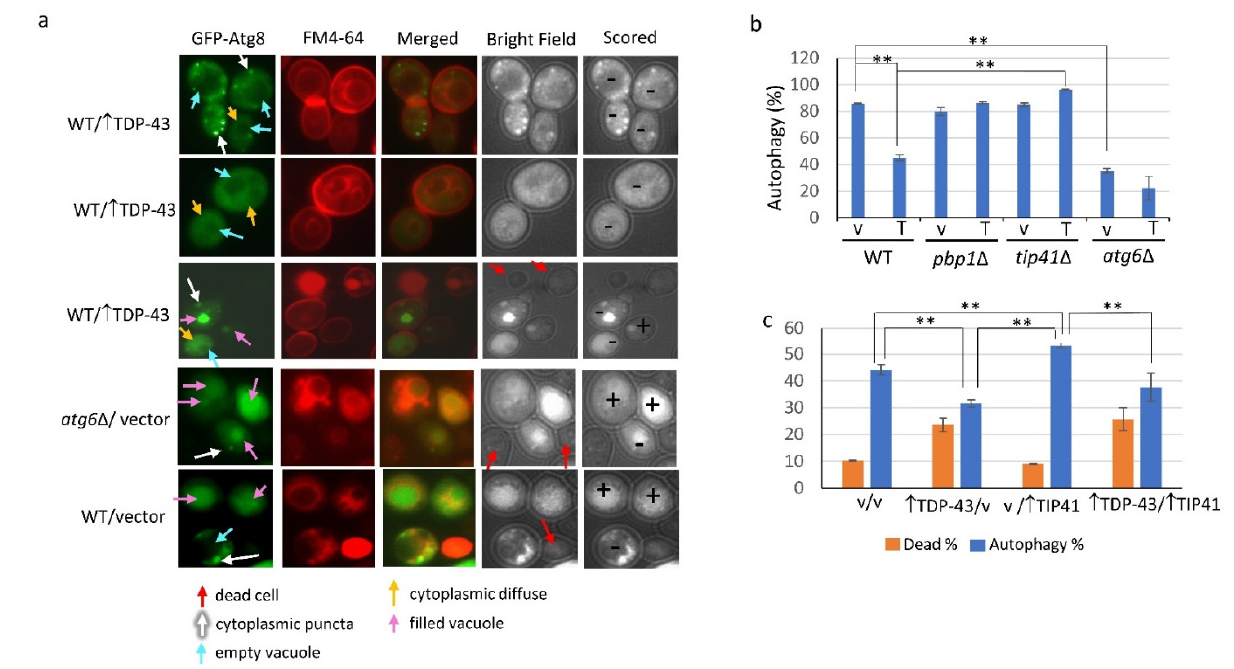
Figure 2. Microscopic assay showing TDP-43 overexpression reduces autophagy. Triple transformants analyzed in Figure 1a were inoculated at 0.02 OD 600 in the presence of 1.6 nM FM4-64 to visualize cell membranes and vacuoles in plasmid selective galactose supplemented with 2% raffinose and 50 µ M Cu ++ for 18 hrs at 30 ◦ C with shaking. Cells were scored for autophagy using the CUP1 controlled GFP-ATG8 reporter by microscopic determination of the location of the fluorescence. ( a ) FM4-64 staining, trypan blue staining and GFP fluorescence of cells expressing GFP-ATG8 are shown in representative cells to illustrate scoring. Cells with accumulation of diffuse fluorescence in the cytoplasm without a concentration of fluorescence in the vacuole, or fluorescence in the cytoplasm in foci even with accumulation in the vacuole, were scored as having delayed or blocked autophagy (-). Cells with fluorescence in the vacuole without punctate cytoplasmic foci, or live cells with no fluorescence, were scored as having autophagy (+). Dead cells were detected with trypan blue staining seen in bright field. ( b ) The fraction of WT, pbp1 ∆ , tip41 ∆ , or atg6 ∆ cells exhibiting autophagy. The cells shown in Figure 2a are representative examples of what cells looked like when scored as indicated. All types of cells were found in all the strains examined. Still, we have listed the strains the cells shown were found in for completeness. ( c ) The fraction of WT cells exhibiting autophagy and alive with and without overexpression of TDP-43. Cells were grown on selective galactose plates supplemented with 1.6 nM FM4-64, 1% raffinose, and 50 µM Cu ++ for 18 hrs at 30 °C and scored for autophagy as described in ( a ). The fraction of dead cells was determined as in Figure 1b. Error bars represent the SEM calculated from three independent transformants. About 150-700 cells were scored for each transformant. ** indicates p < 0.05 in two-tailed t -test.